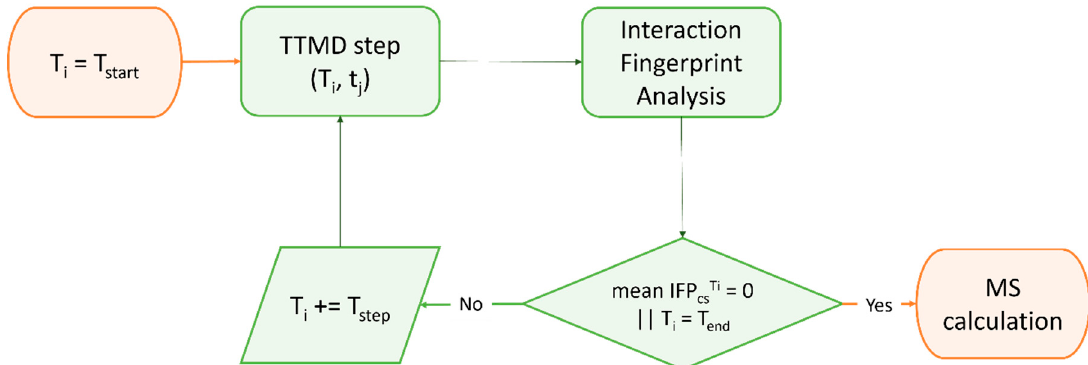
Figure 4. Workflow of a Thermal Titration Molecular Dynamics (TTMD) simulation. The time-dependent conservation of the native binding mode within a protein–ligand complex of interest is monitored with a scoring function based on interaction fingerprint through a series of short molecular dynamics simulations performed at progressively increasing temperatures. The simulation is carried out until the target temperature is reached or the dissociation process is completed. A coefficient called MS is then calculated and used to rank ligands based on the persistence of their native binding mode.